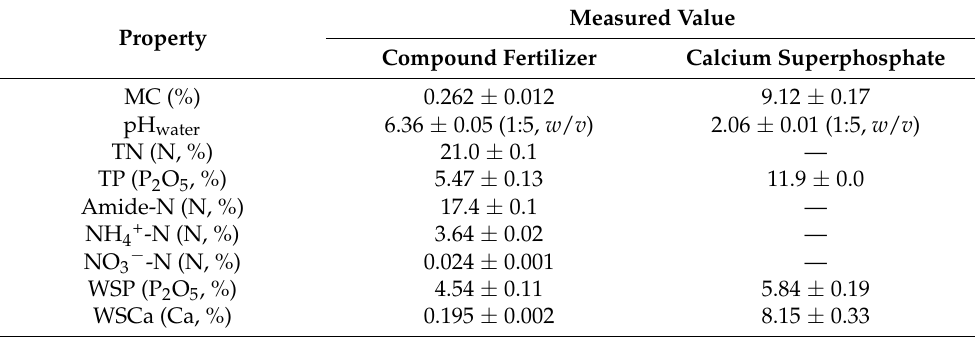
Table 2. Basic physicochemical properties (wet basis) of the compound fertilizer and calcium superphosphate used in the present